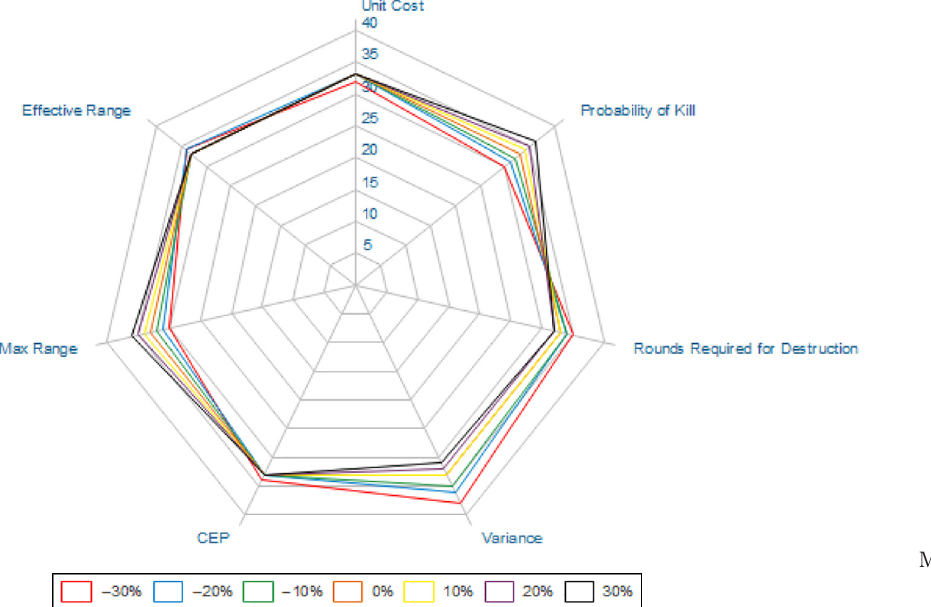
Figure 12. M795 total value